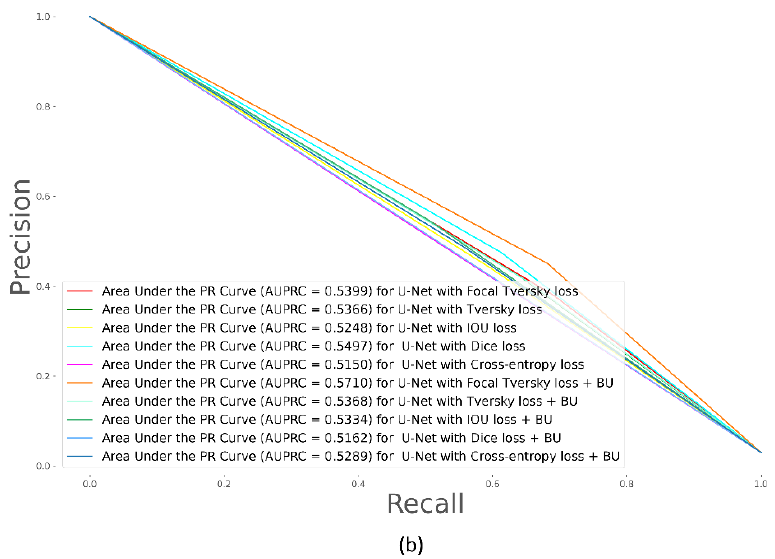
Figure 3. Test performance curves for the VGG-16-based U-Net model trained with various loss functions. ( a ) ROC and ( b ) PR curves. The area under the PR curve (AUPRC) gives the mAP values. The AUC and AUPRC curves shown in brown color denote superior performance achieved by the models trained with Focal Tversky and Focal Tversky + BU losses, respectively.